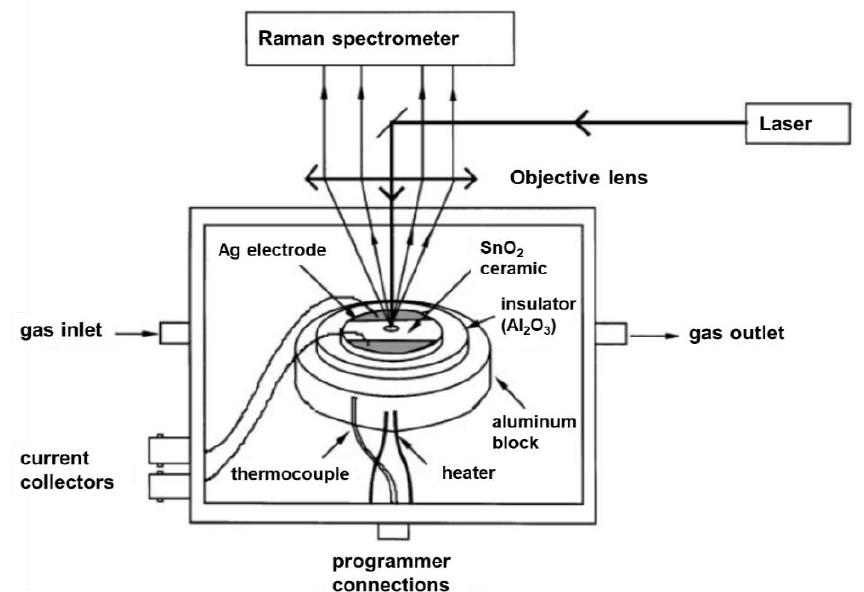
Figure 1. Schematic diagram of an in situ cell used for coupled Raman and impedance spectroscopic measurements. Modified from [22].